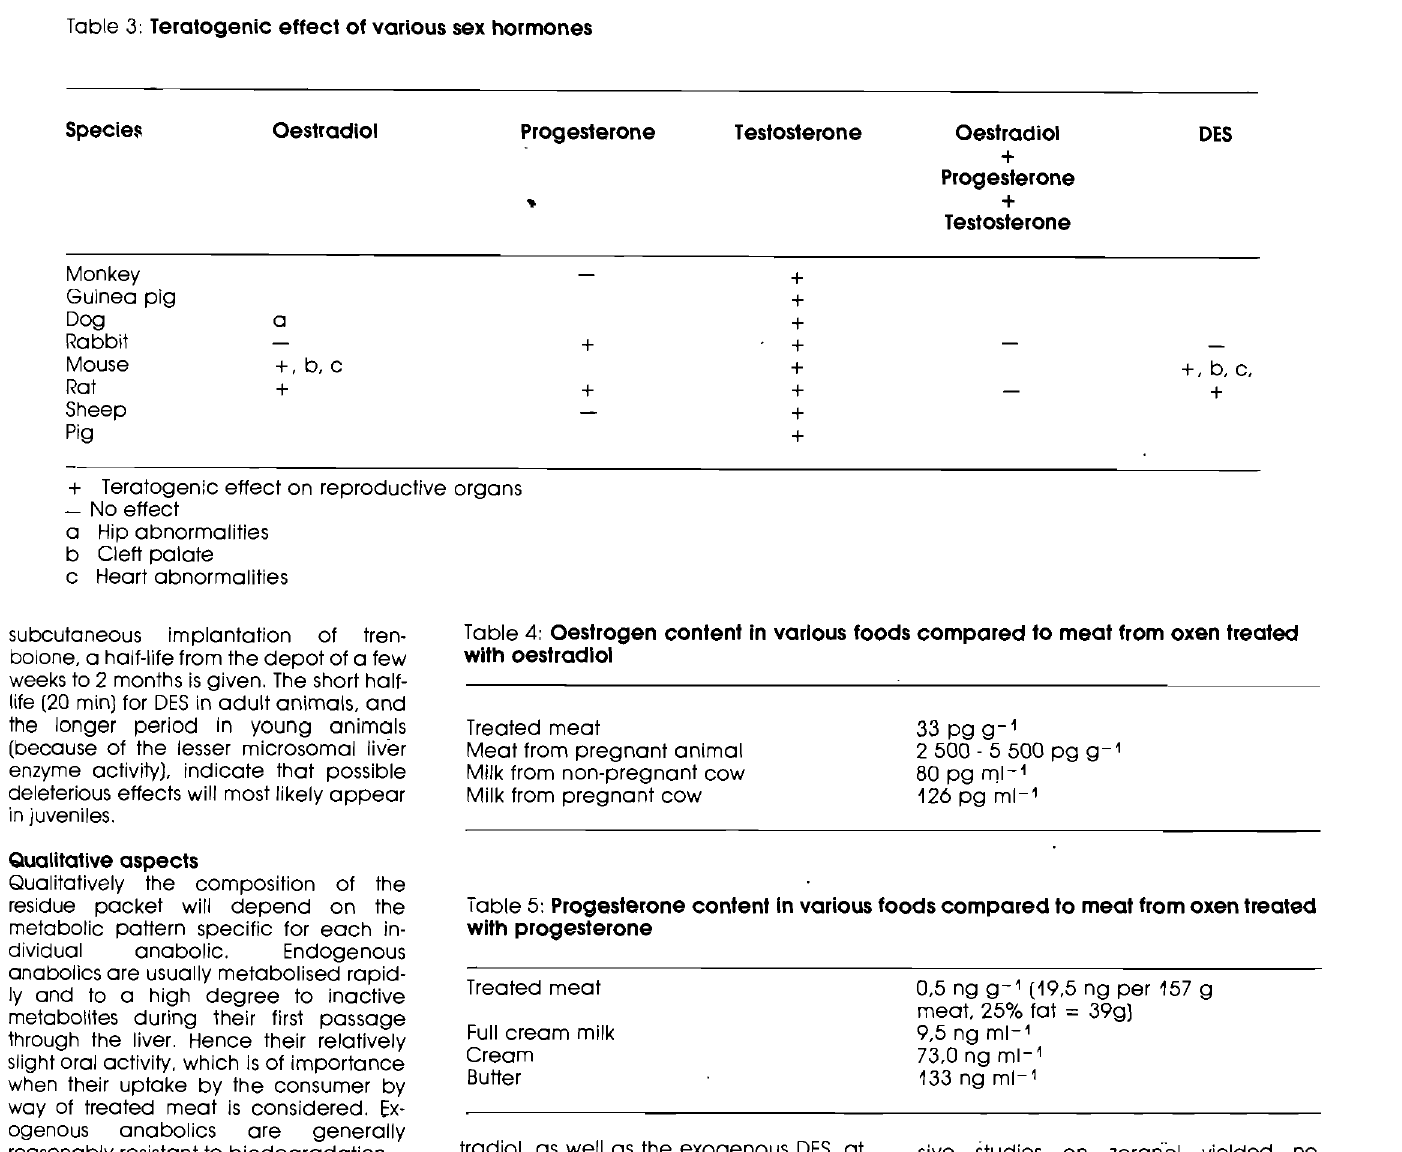
Table 3: Teratogenic effect of various sex hormones